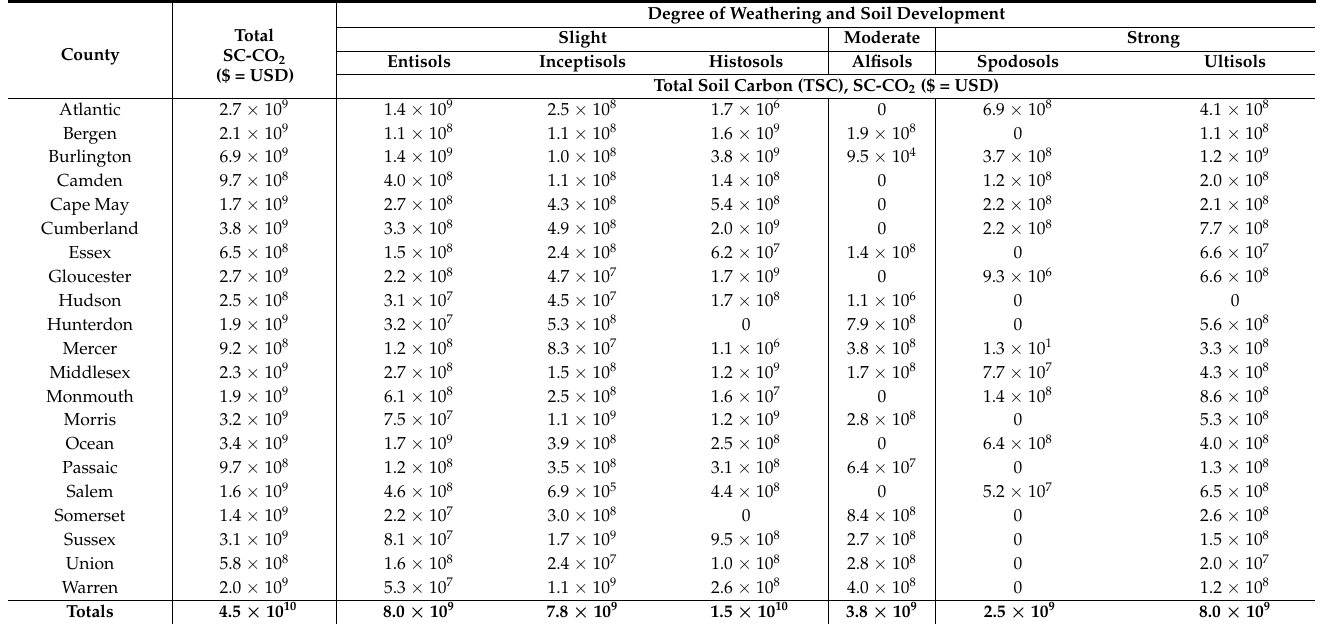
Table 7. Midpoint monetary values of total soil carbon (TSC) by soil order and county for the state of New Jersey (USA), based on the areas shown in Table 3 and the area-normalized midpoint monetary values in Table